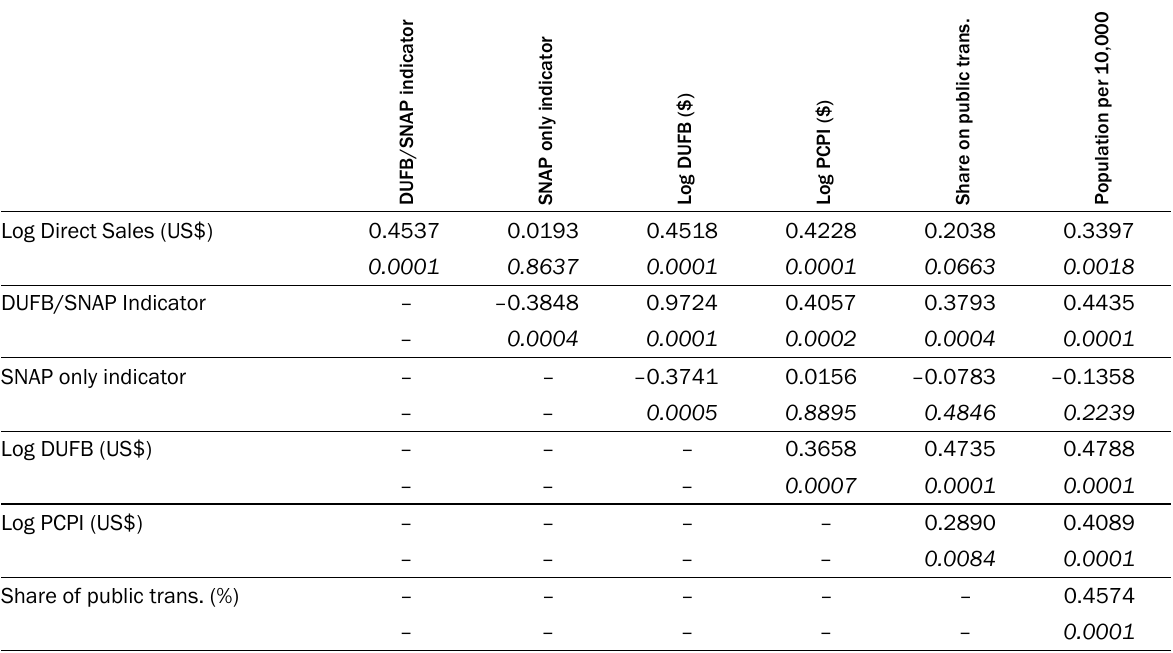
Table 3. Correlations of County-Level Data in Regression Model,